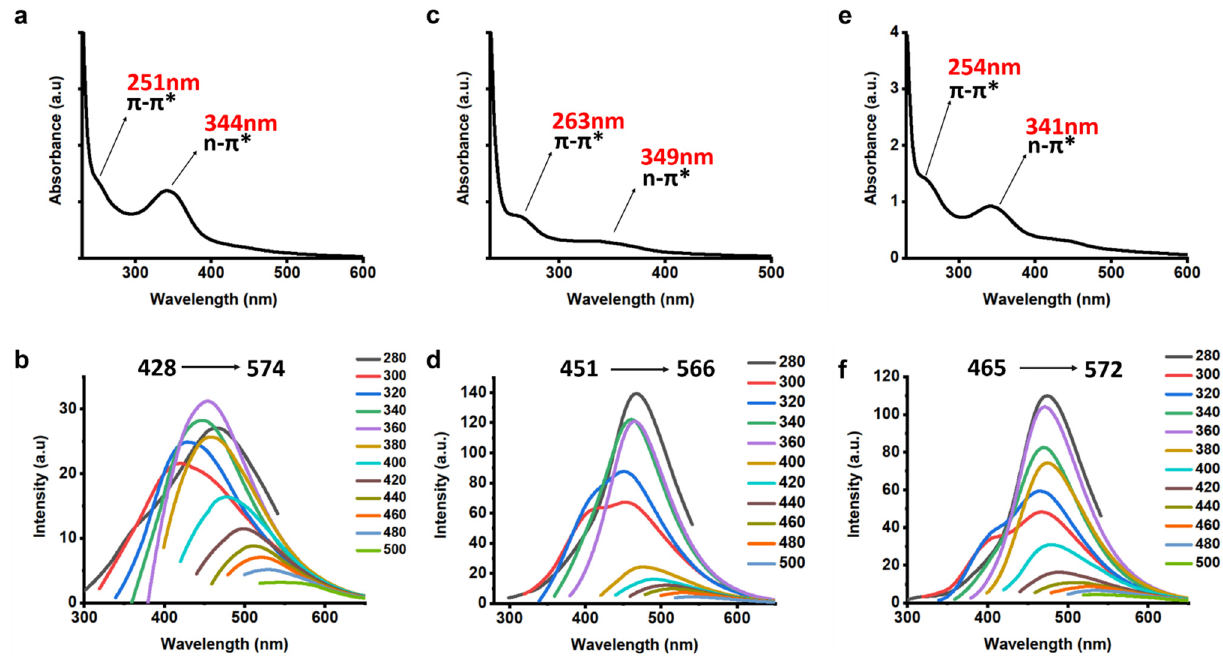
Figure 1. UV-vis and fluorescence spectra collected at different excitation wavelengths of CQDs prepared at different synthesis times: 3 h ( a , b ), 12 h ( c , d ), and 24 h ( e , f ). The synthesis